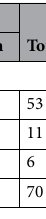
Table 2. Reference standard and results of CT-guided percutaneous core needle